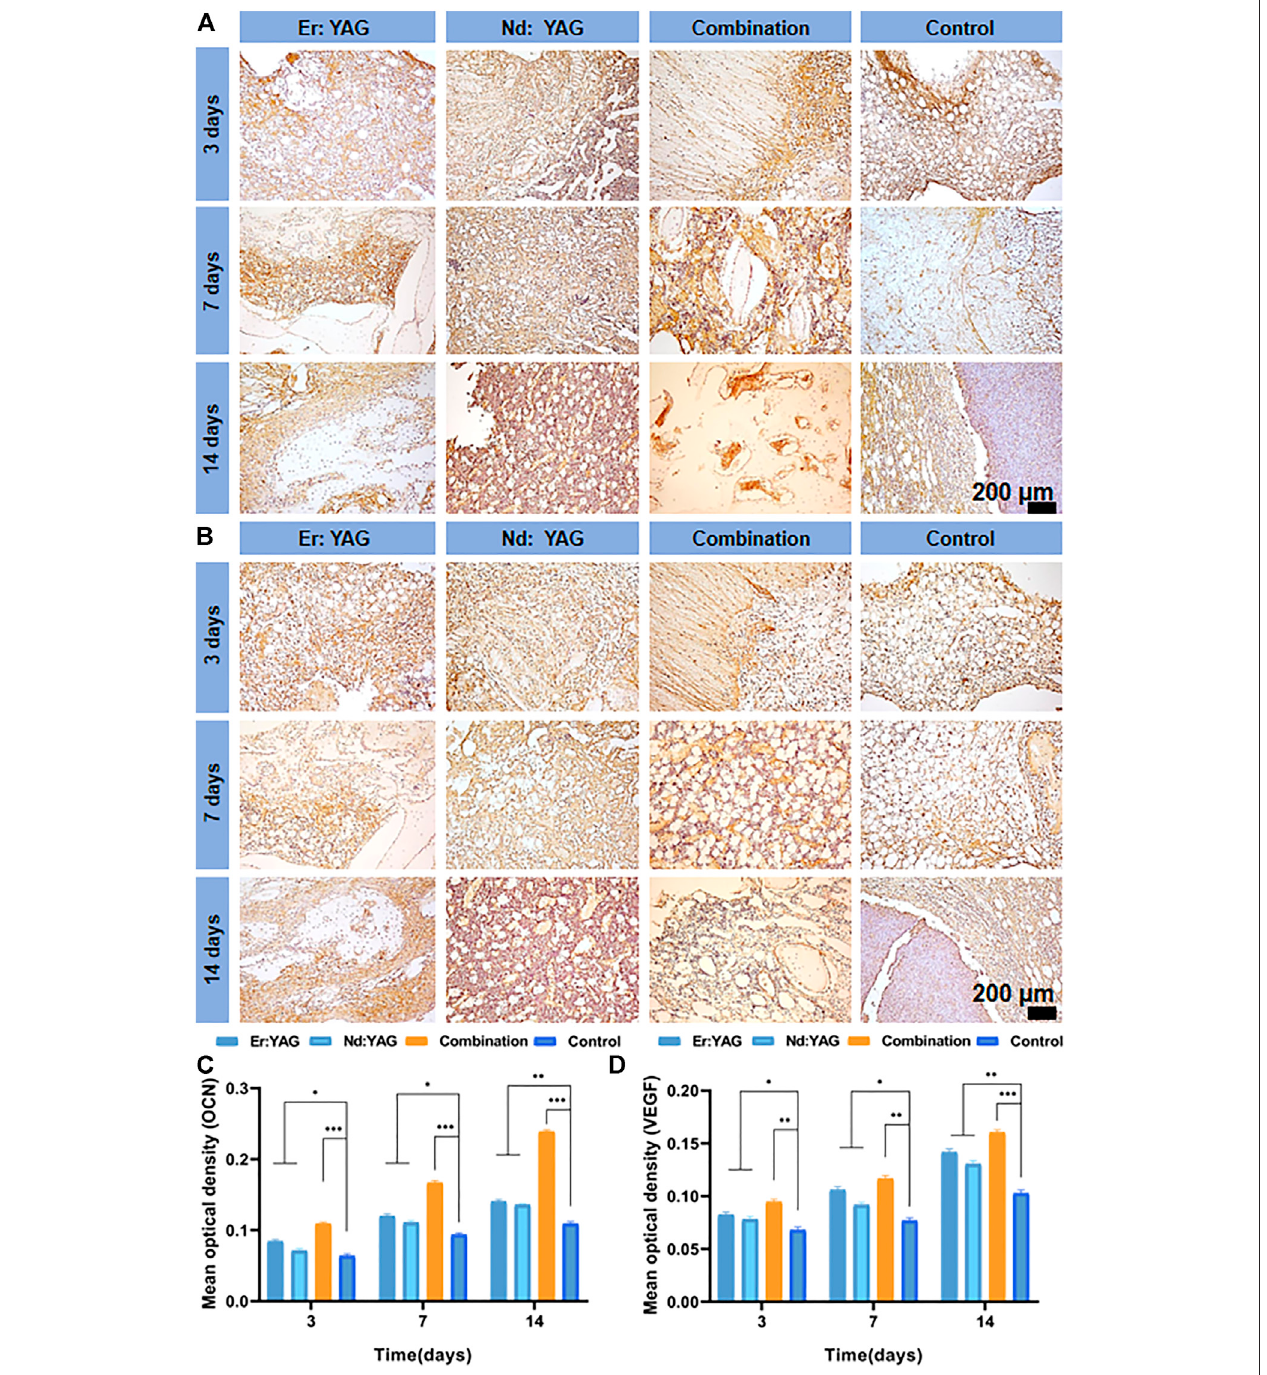
FIGURE4 | Immunohistochemical analysisofthe bone around theimplant. Representativeimagesofthe expressions of (A) OCN, (B) VEGF,and (C) mean optical density of positive areas in the bone around the implants at 3, 7, and 14 days after implantation. ( n = 3, *indicates signi fi cant differences between the groups, * p < 0.05; ** p < 0.01; *** p <